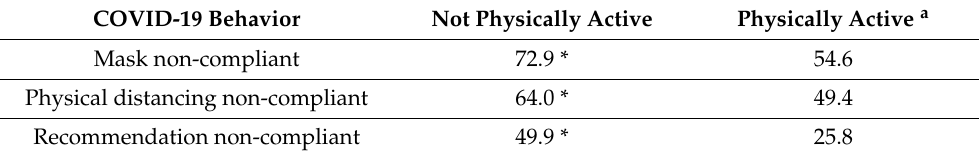
Table 1. COVID-19 behaviors in non-physically active and physically active individuals. COVID-19